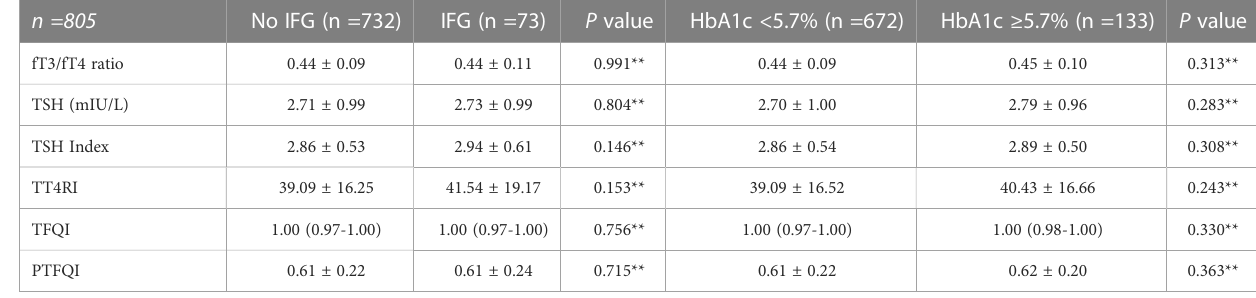
TABLE 4 ORs (95% CI) of IGT for 1 mIU/L increase of TSH or 1 unit of TSHI, TT4RI or PTFQI.